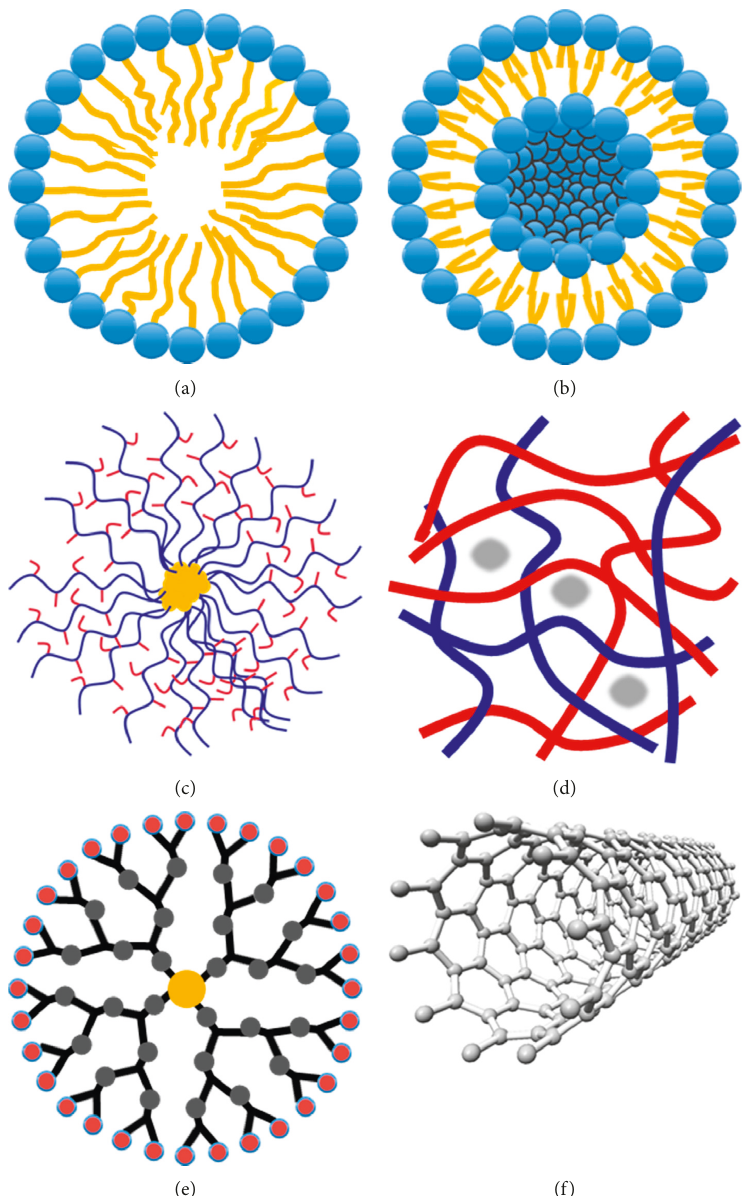
Figure 1: Schematic diagrams of 6 types of nanocarriers. (a) Micelle. (b) Liposome. (c) Polymeric nanoparticle. (d) Hydrogel nanoparticle. (e) Dendrimer. (f) Carbon